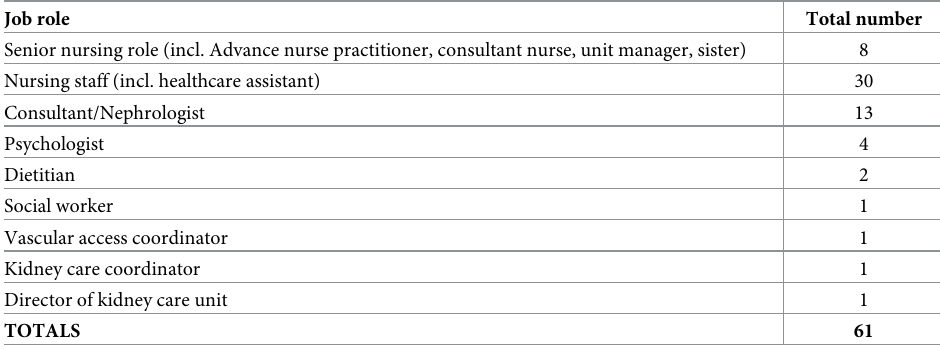
Table 1. Job roles of participants in interviews or focus